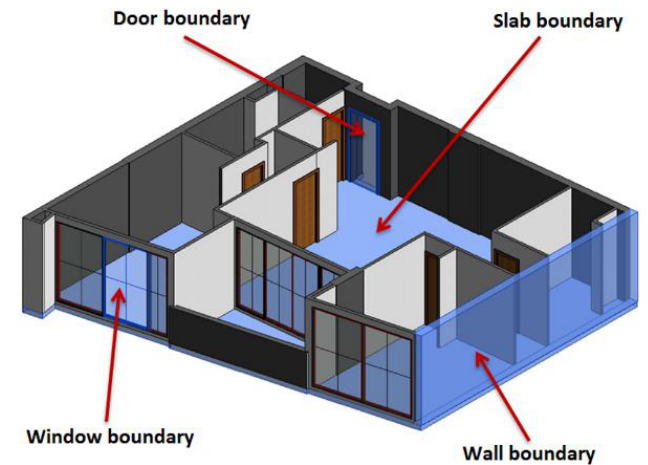
Figure 1. Common types of 3D legal boundaries in buildings, adapted from [28].